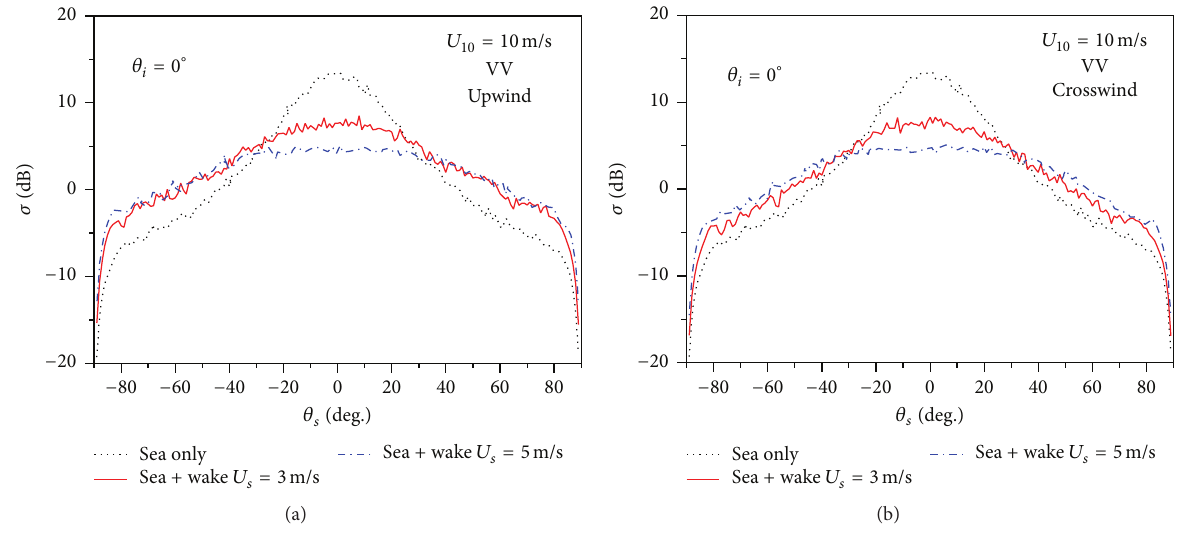
Figure 11: The angular distribution of bistatic scattering coefficient of sea surface with and without a ship-induced kelvin wake for VV- polarization at wind speed 𝑈 10 = 10 m/s. (a) Upwind case and (b) crosswind